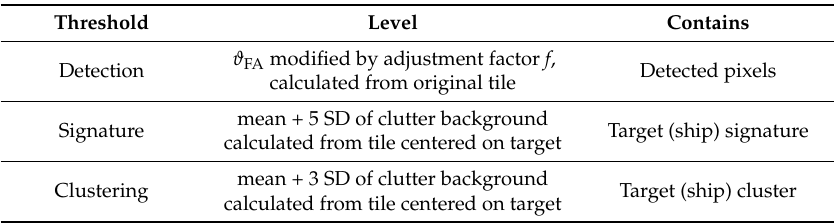
Table 2. Overview of the thresholds used, from high to